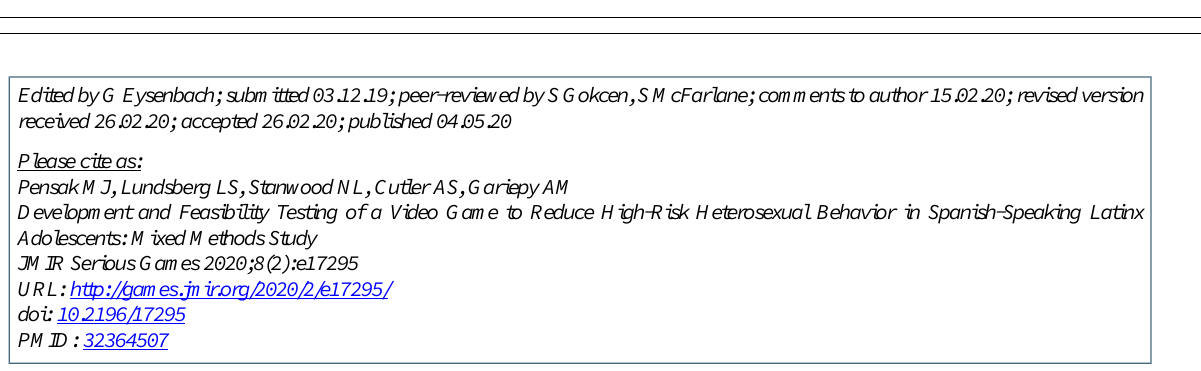
Abbreviations CDC: Centers for Disease Control and